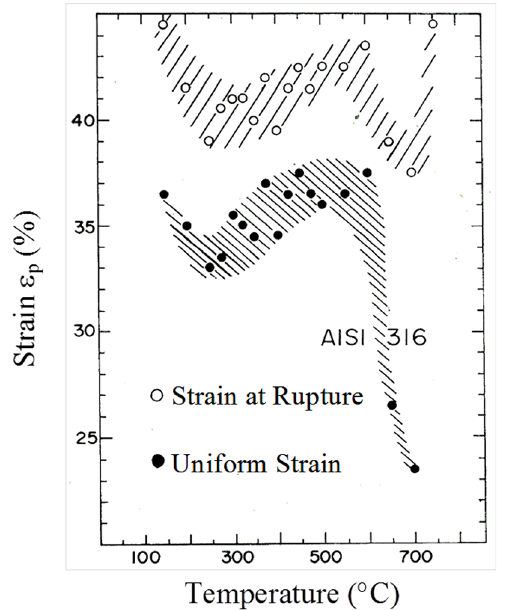
Figure 3. Temperature dependence of uniform strain and total strain for AISI 316 stainless steel.